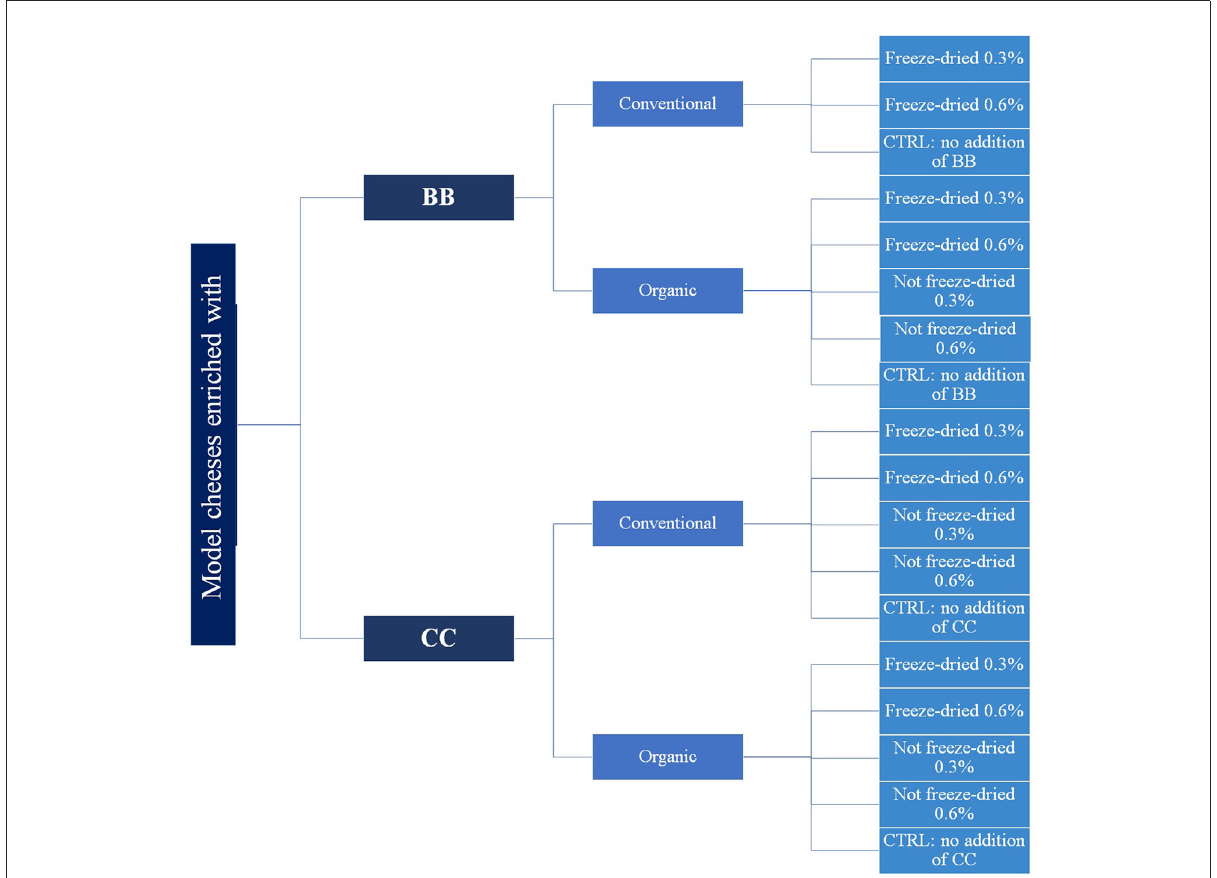
FIGURE1 Experimental design of cheese manufacturing. Four different conditions were tested in cheese samples: conventional freeze-dried berries, organic freeze-dried berries, conventional not freeze-dried berries, and organic not freeze-dried berries. For each of these conditions, two different percentages of berries were added: 0.3 and 0.6% dry weight w/v milk volume. A cheese without the addition of berries was processed for each trial (CTRL). All the experimental conditions were carried out in